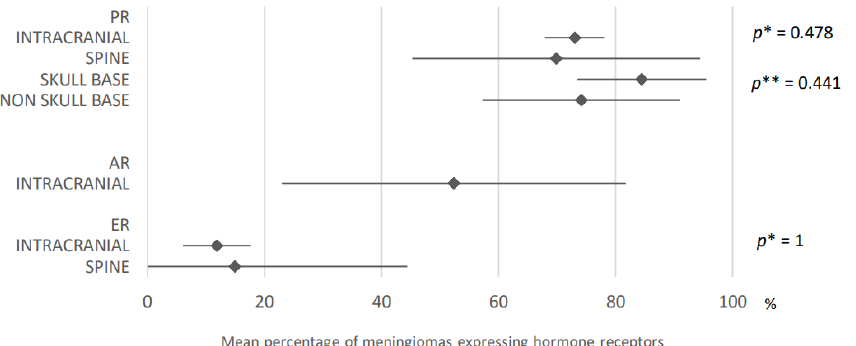
Figure 9. Comparison of hormone receptors expression in meningiomas according to their